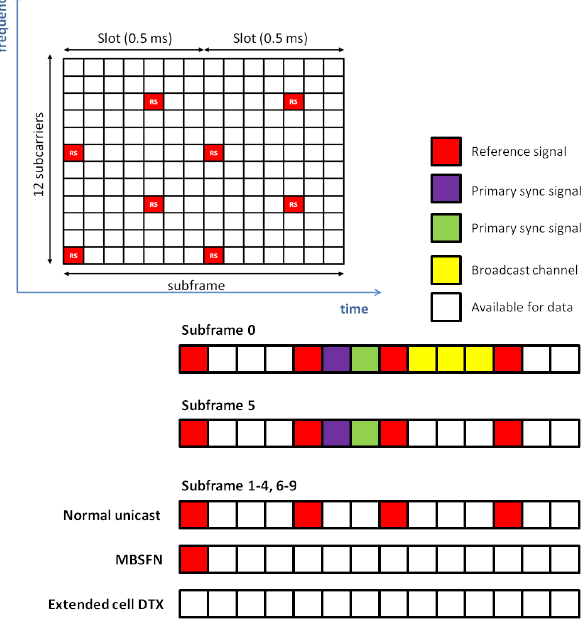
Figure 10. Cell DTX: power amplifiers can be put in low power state if there is no downlink